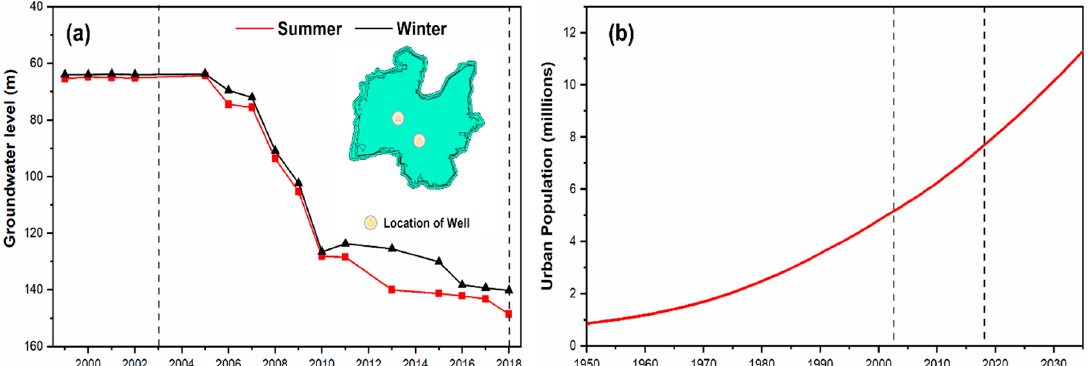
Figure 10. ( a ) Groundwater table level (meters below the surface level) in the Ahmedabad urban area